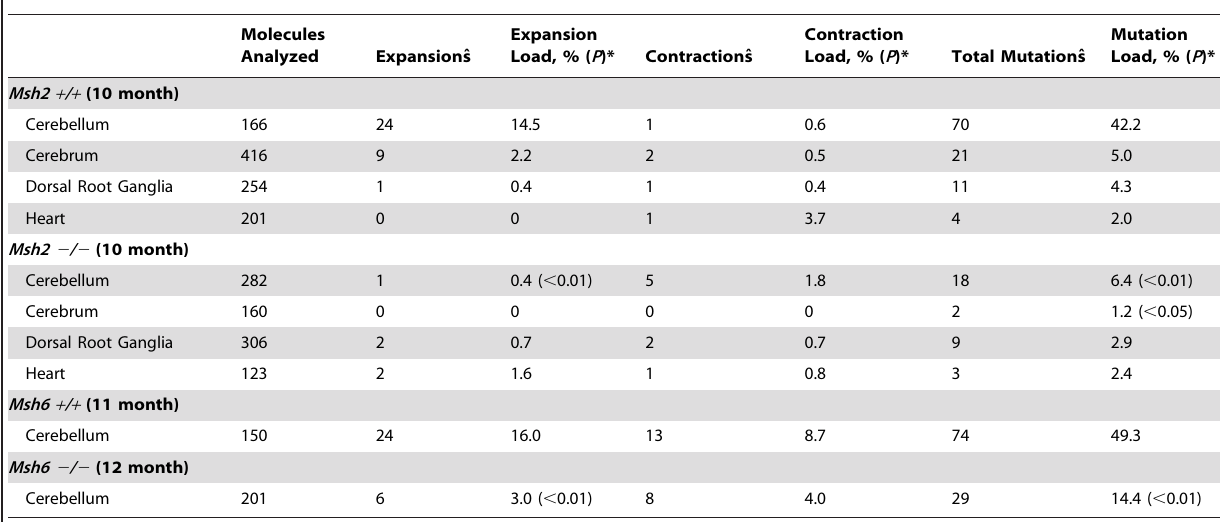
Table 1. Effect of Msh2 and Msh6 on instability in somatic tissues.